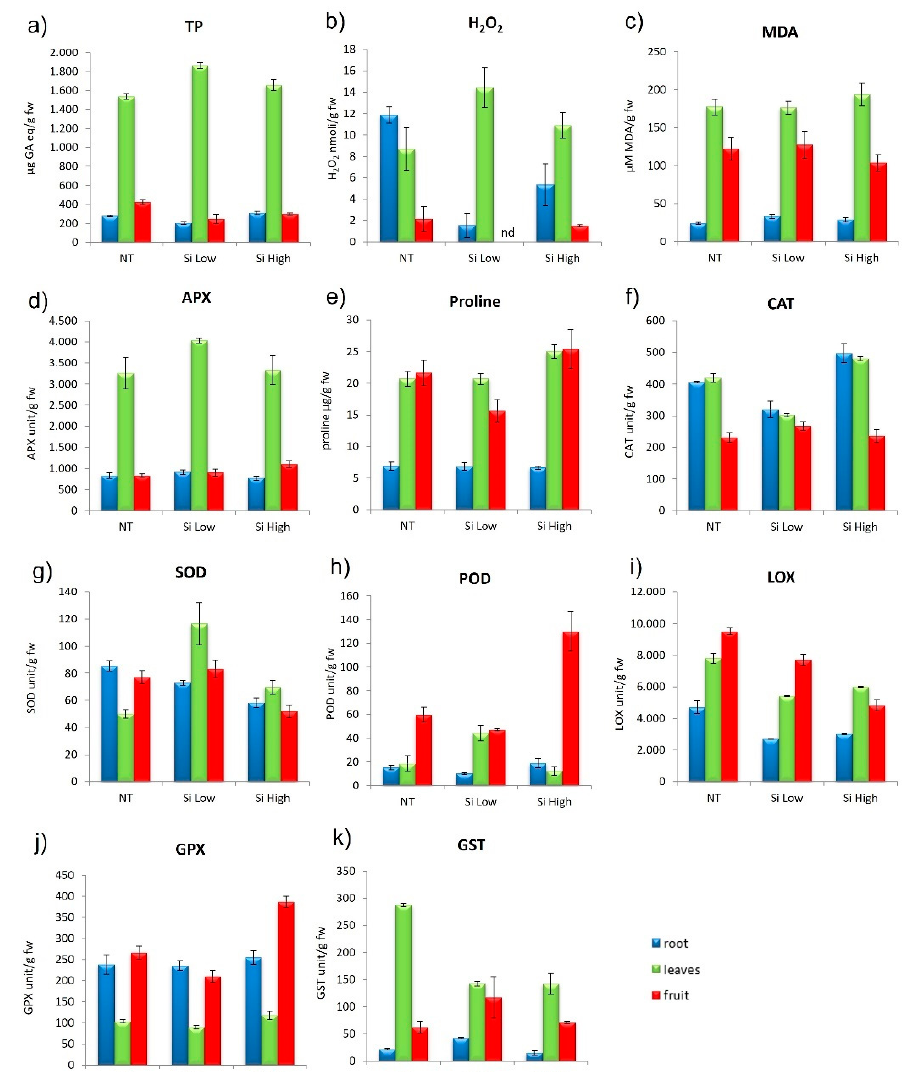
Figure 3. Effect of Si Low and Si High physiological parameters in cvs. Aragon: ( a ) total phenolic (TP), ( b ) hydrogen peroxide (H 2 O 2 ), ( c ) lipid peroxidation (MDA), ( d ) ascorbate peroxidase (APX), ( e ) proline, ( f ) catalase activity (CAT), ( g ) superoxide dismutase activity (SOD), ( h ) peroxidase activity (POD), ( i ) lipoxygenase (LOX), ( j ) glutathione peroxidase (GPX), ( k ) Glutathione S- transferases (GST). Values equal to 0 means below detection limit (nd). ANOVA was performed followed by Tukey’s HSD test. Tukey’s p values are explicated in Tables S4 and S5.